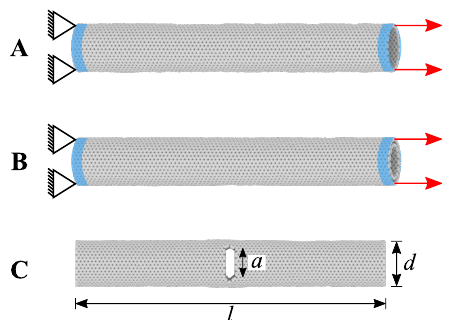
Figure 4. MD simulation setup: Schematic representation of ( A ) SWCNT and ( B ) DWCNT pulling. ( C ) Describes the dimensions of cracked CNT, where l , d and a represent the length, diameter and crack length, respectively. All the models were fixed at one end and pulled at another end.